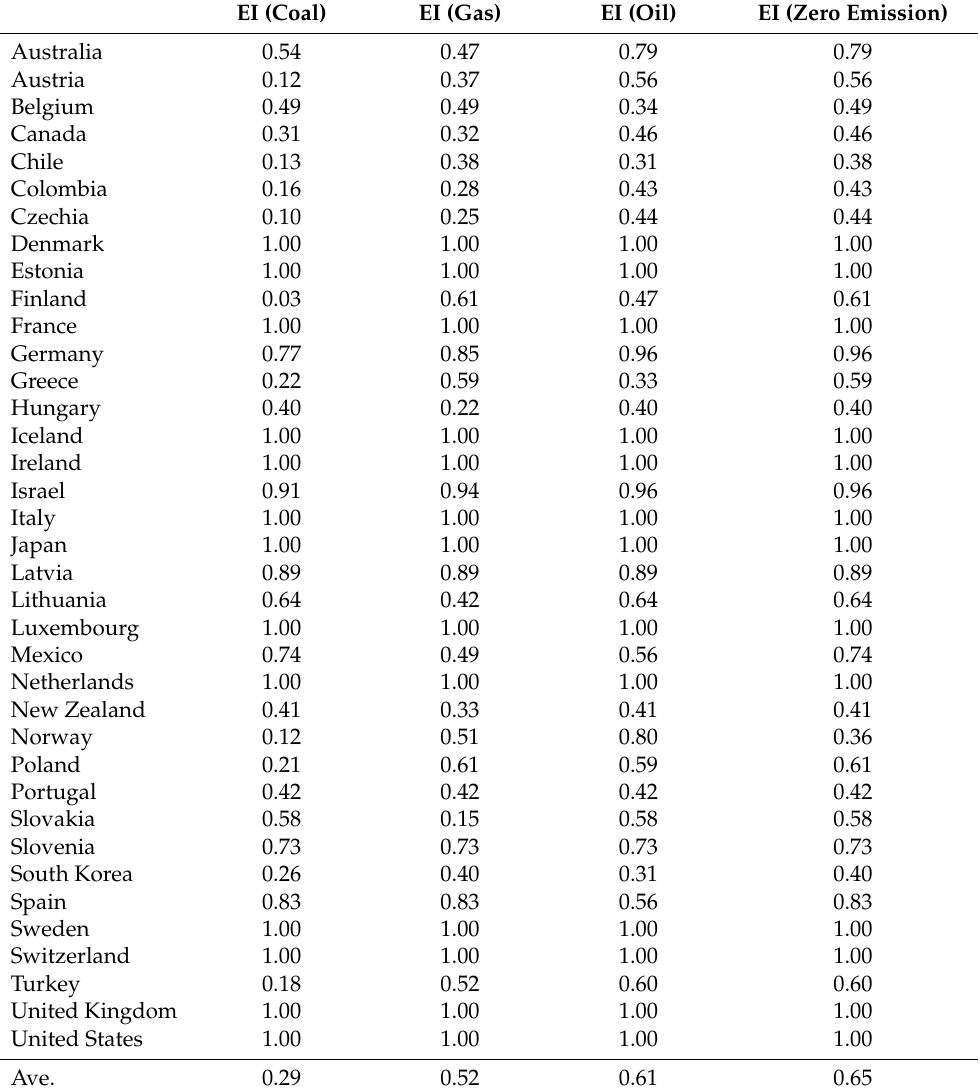
Table 6. Ratio between optimal and original EI (REI) scores among OECD nations (2019). EI